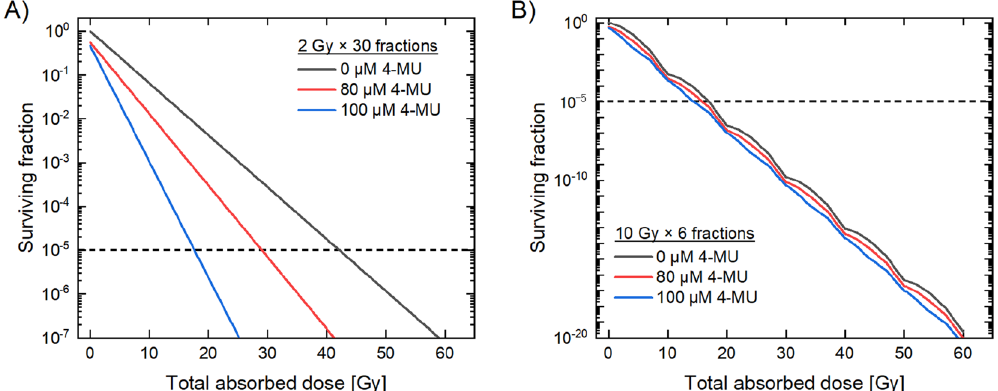
Figure 5. The cell survival during fractionated irradiation under 4-MU administration. Dose–response curve of HT1080 cells for each 4-MU concentration irradiated by ( A ) 2 Gy/fraction scheme or ( B ) 10 Gy/fraction scheme. Charcoal line is the dose–response curve of the non-treated cells, red line is the curve of the 80 μM 4-MU treated cells, and blue line is the curve of the 100 μM 4-MU treated cells. The horizontal black dotted line represents the surviving fraction S c = 10 –5